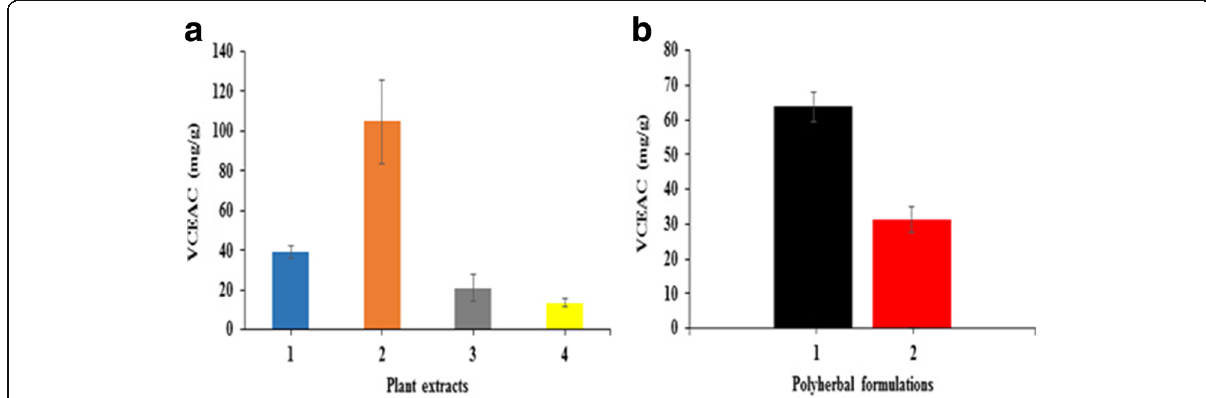
Fig. 5 a Comparison of total reducing power of methanolic extracts of terminal meristem of Musa paradisiaca flower (1), Nyctanthes arbor-tristis leaves (2), unripe fruit pulp of Aegle marmelos (3), and ripe fruit pulp of Aegle marmelos (4) in terms of VCEAC. b Comparison of total reducing power of methanolic extracts of poly herbal formulations PHF1 (1) and PHF2 (2) in terms of VCEAC